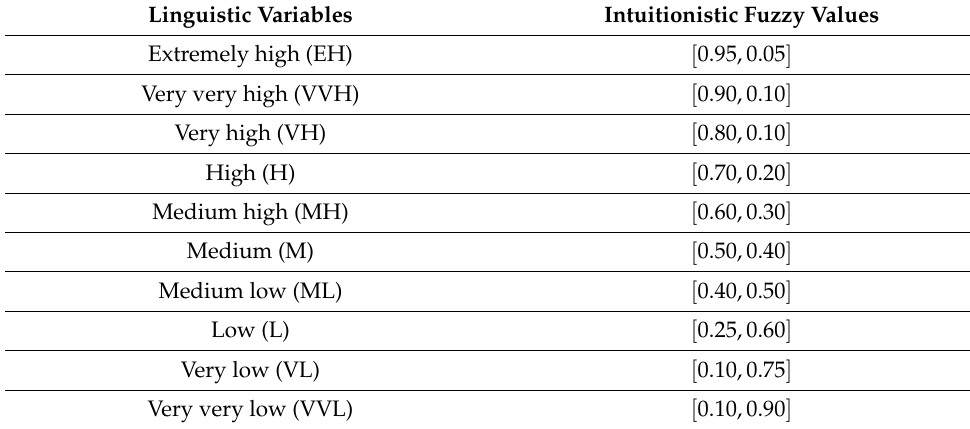
Figure 2. Criteria for assessment of energy projects. Table 1. Linguistic terms for expert judgments.